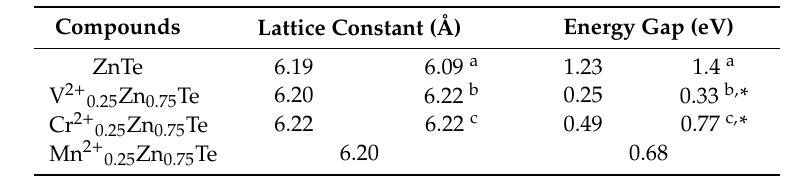
Table 1. The lattice constants of optimized atomic structures of ZnTe and TM 2+0.25 Zn 0.75 Te ( TM = V, Cr, Mn) fit other theoretical values. The corresponding band gaps are compared with other calculated values. Compounds Lattice Constant (Å) Energy Gap (eV)